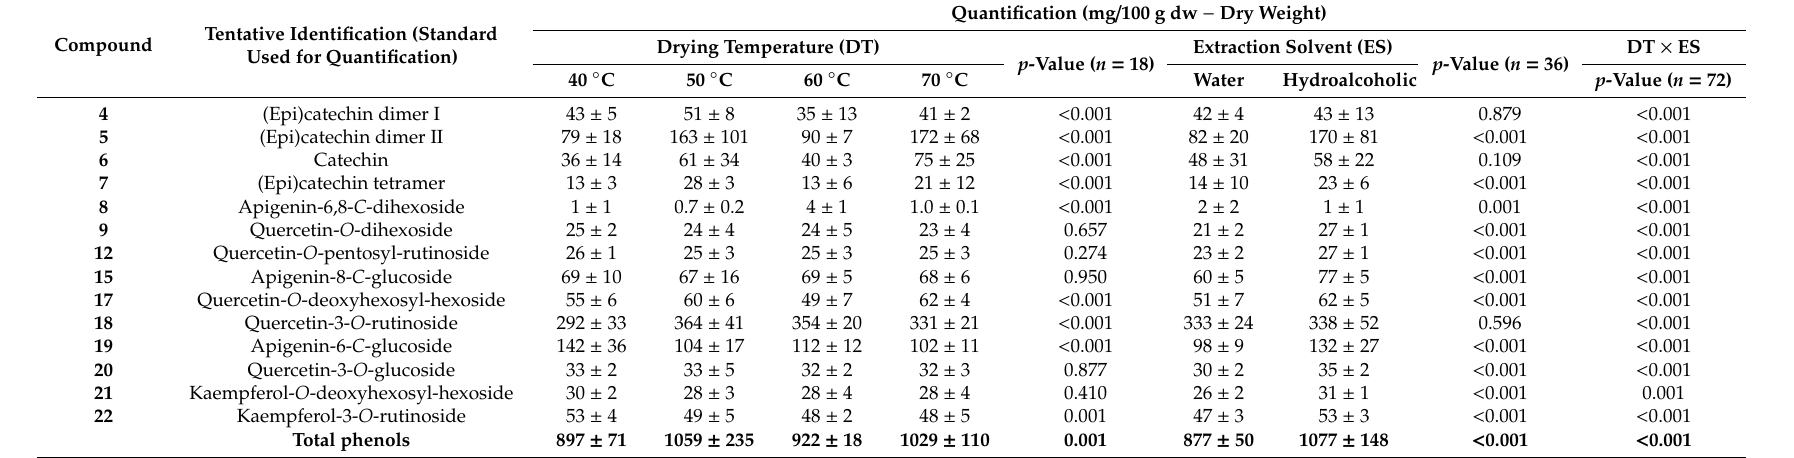
Table 2. Phenolic compound quantification (mg / g extract) in C. urucurana Baill. leaves submitted to di ff erent drying and extraction conditions.